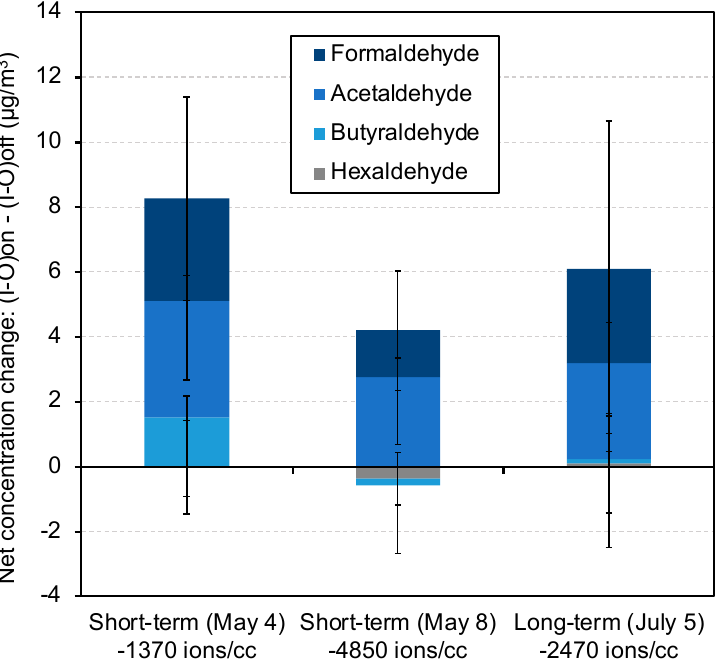
Figure 8. Net change of aldehyde concentrations (and propagated uncertainties) measured during air cleaner operation compared to air cleaner off conditions for compounds on the TO-11A analyte list that were detected above reporting limits (RLs) in samples collected during the three natural condition tests (two short-term and one long-term). Positive values represent net production and negative values represent net removal. Net changes are calculated as the differences in differences of inside minus outside (I–O) chamber concentrations measured during EAC on versus off conditions.